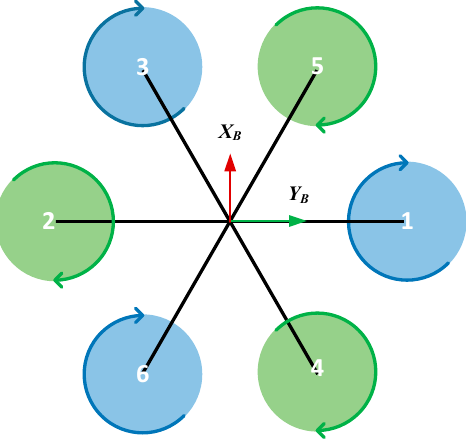
Figure 2. Illustration of hex-rotor.